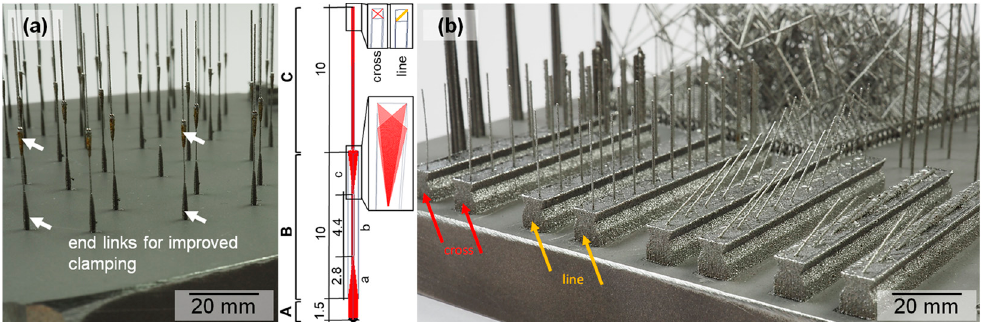
Figure 1. Macroscopic images of the ( a ) filigree tensile specimens (20 mm in height) used for mechanical testing in a self-assembled micro testing setup (see Figure 2). The tensile specimens span from handle to handle while the upper part was clipped from the specimen and kept for further analysis (for further explanations and the schematic drawing please see the text in Section 2.1). An image of single struts with varying diameters ( P = 200 W, v = 500 mm/s) is shown in ( b ). The arrows mark the specimen rows produced with line (yellow) and cross (red) quasi-P scanning strategy. The highlighted specimens, with respect to their shape and diameter, are compared in Figure 3.